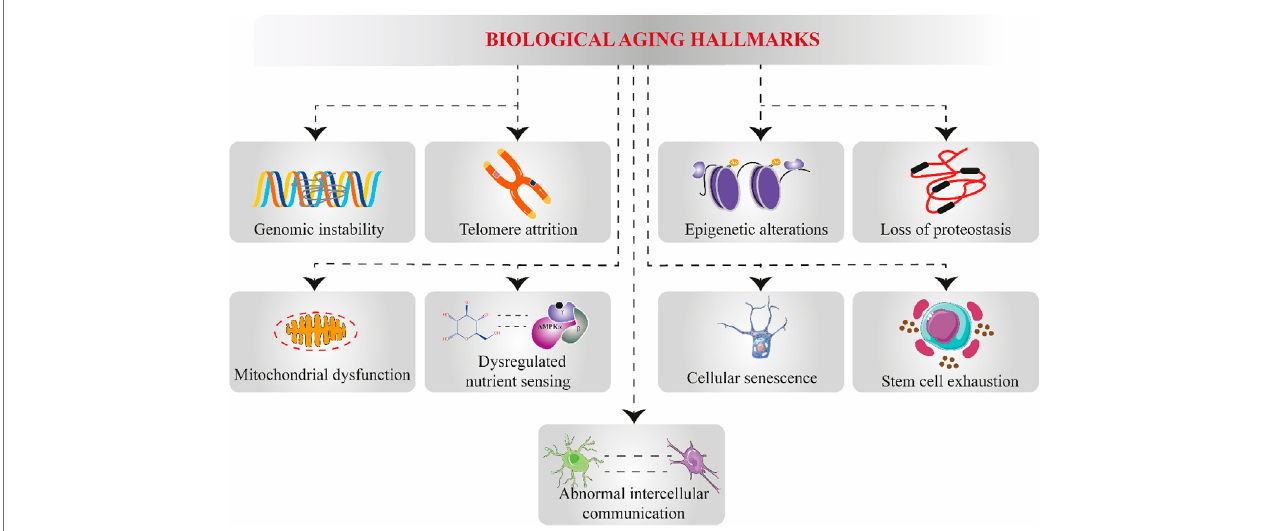
FIGURE 2 | Systematic representation of causal hallmarks underlying biological aging. Biological aging results from multifaceted cellular alterations and breakdowns, which are commonly referred to as “ aging hallmarks. ” These aging hallmarks include genomic instability, telomere attrition, epigenetic alterations, proteostasis loss, mitochondrial dysfunction, dysregulated nutrient-sensing pathways, cellular senescence, stem cell exhaustion, and abnormal intercellular